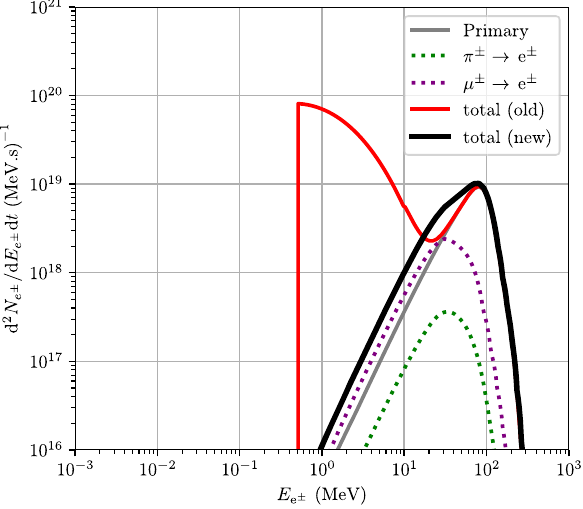
Fig. 5 Comparison between the old PYTHIA extrapolated (solid red) and new Hazma computed (solid black) BlackHawk instantaneous total electron spectrum for a M BH = 5 . 3 × 10 14 g. From left to right: primary electron spectrum (grey solid); muon decay (purple dotted); charged pion decay (green